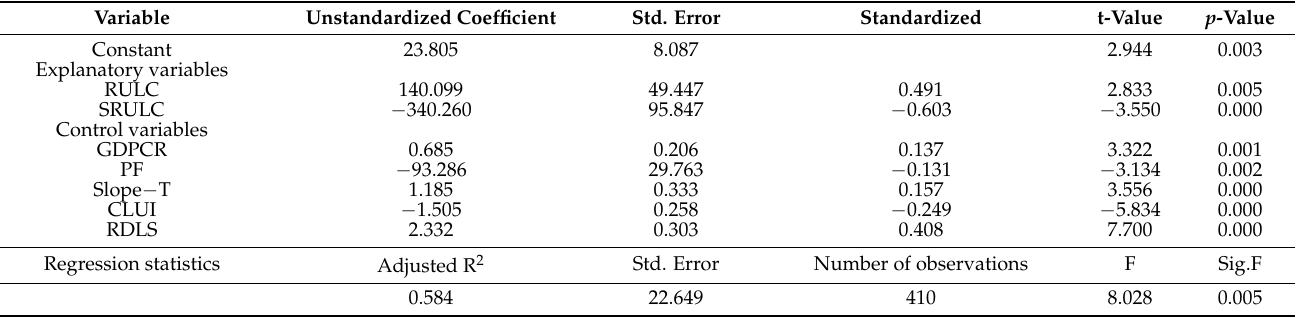
(RULC—rate of urbanization level change; SRULC—square of RULC; GDPCR—GDP change rate; PF—coefficient of variation of precipita- tion; Slope − T—slope of temperature change; CLUI—change in LUI (comprehensive index of land-use intensity); RDLS—relief degree of land